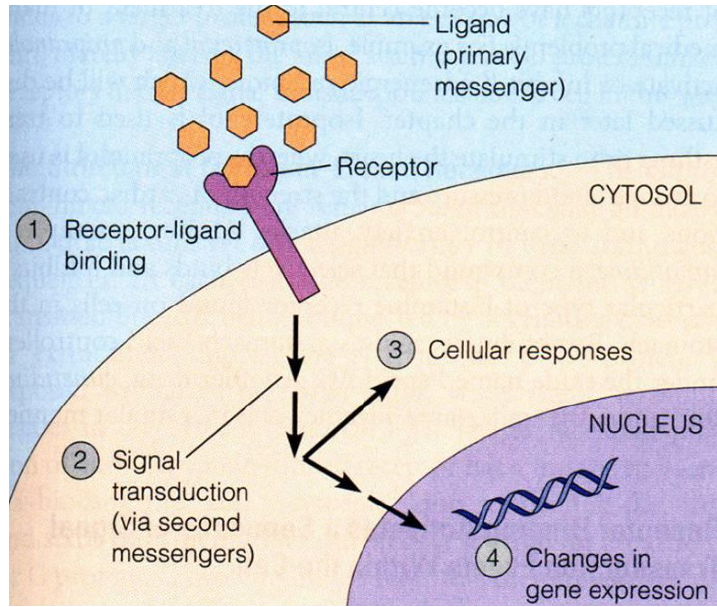
Figure 1. Ligand–receptor connection model for biological